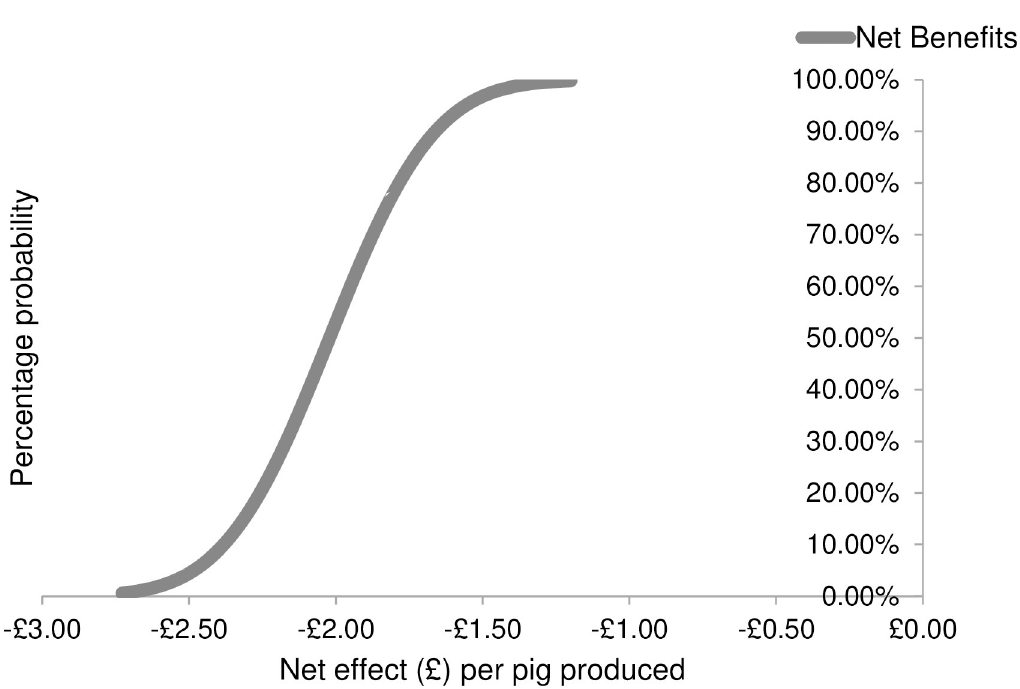
Fig 2. The Cumulative Distribution Function (CDF) for housing pigs in large social groups of 100+ as modelled through stochastic partial budgeting.